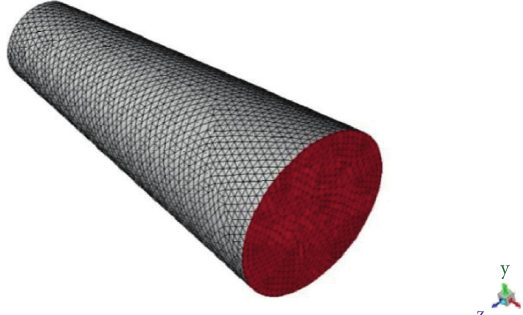
Figure 7: Computational domain grid model.